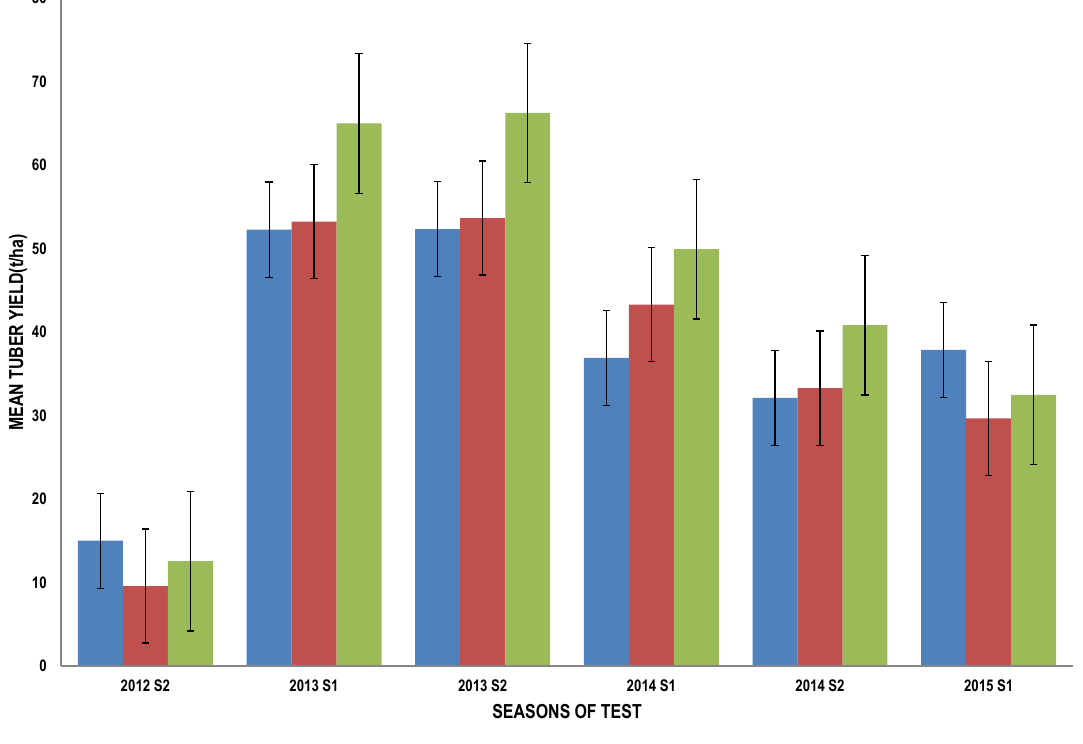
Figure 3: Mean tuber yield of checks and candidate